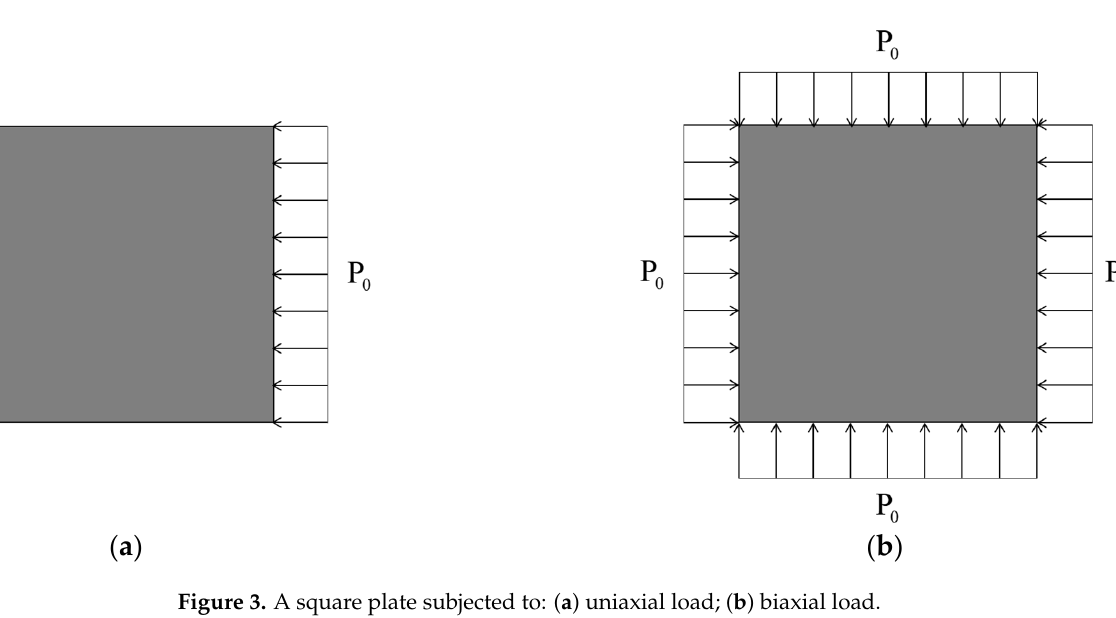
Figure 3. A square plate subjected to: ( a ) uniaxial load; ( b ) biaxial load.